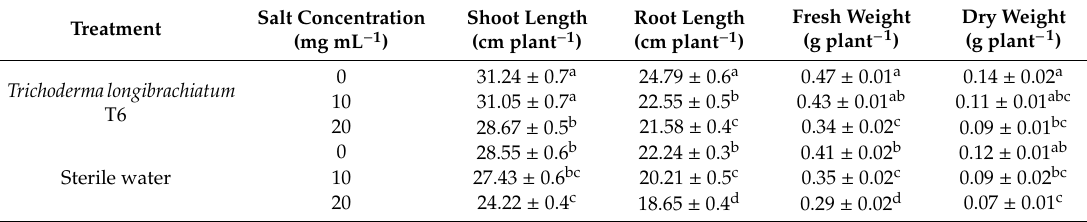
Table 2. E ff ect of the strain Trichoderma longibrachiatum T6 on wheat seedling growth at the di ff erent NaCl solutions.